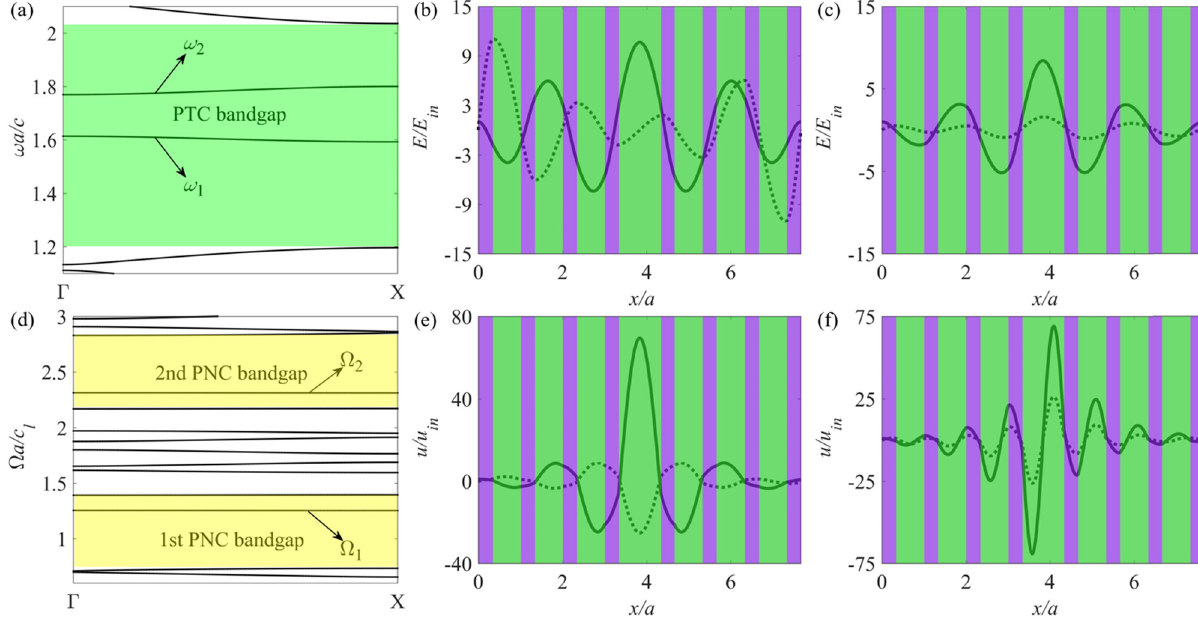
Figure 2: ( a ) Dispersion curve of PTC. Electric distribution of the defect PTC modes ( b ) ω 1 a / c = 1.61176 ( because the imaginary part is much bigger than real part at this frequency, the imaginary is multiplied with 0.1 to show the real part ) , and ( c ) ω 2 a / c = 1.77056. ( d ) Dispersion curve of PNC. Displacement distribution of the defect PNC modes ( e ) Ω a c 1.25492 1 l;SiO dotted line: imaginary part ) . The thickness of the defect layer a d = a